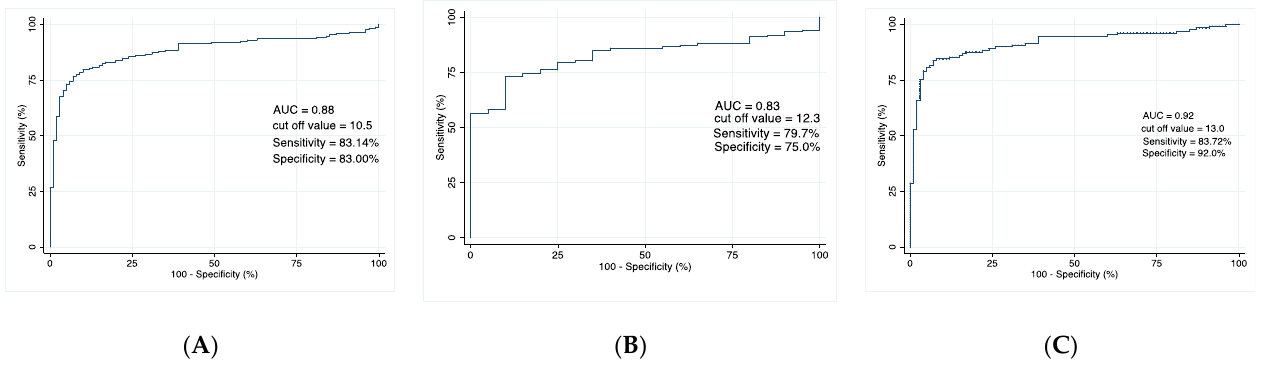
Figure 2. Receiver operating characteristic analysis of preoperative serum concentrations of DJ-1 for the detection of bladder cancer in ( A ) patients with bladder cancer compared with healthy partici- pants, ( B ) patients with bladder cancer compared with patients with urolithiasis, and ( C ) patients with Ta/1 bladder cancer compared with healthy participants. AUC = area under the curve.